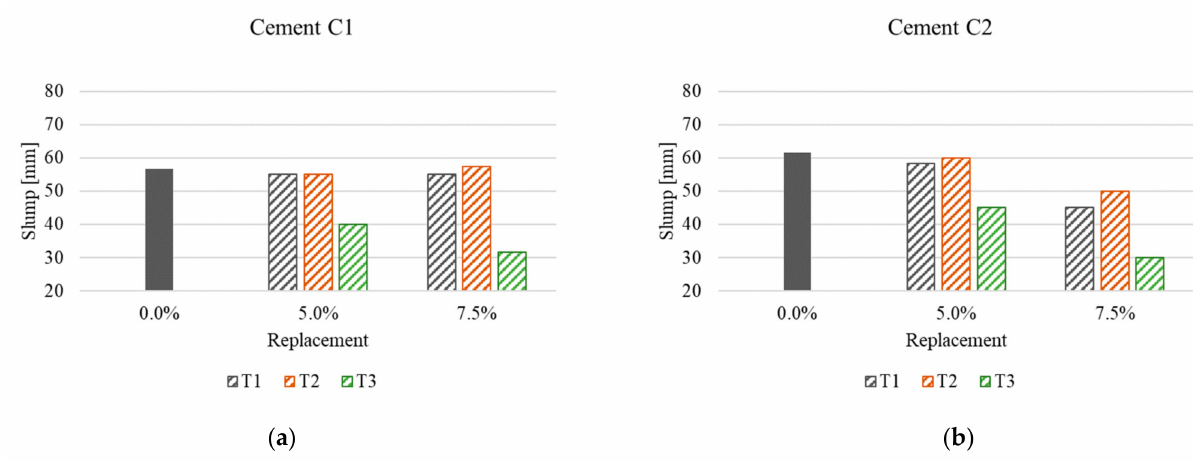
Figure 9. Rubber-added mortar cone slump under treatment R1, at 5% and 7.5% replacement: ( a ) cement C1; ( b ) cement